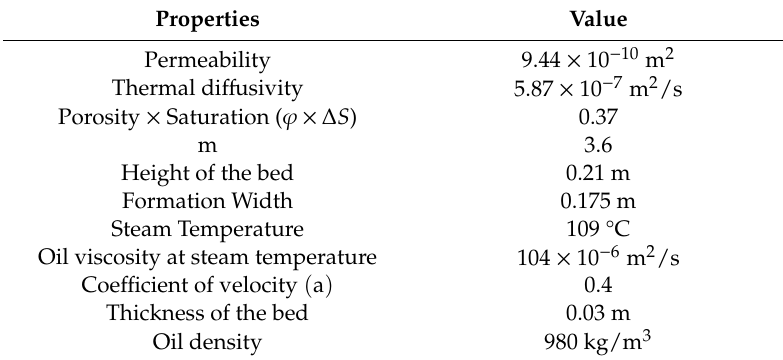
Table 1. Property list of the SAGD experiment [23]. Reproduced with permission from (Chung and Butler), (Annual Technical Meeting); published by (Society of Petroleum Engineers),